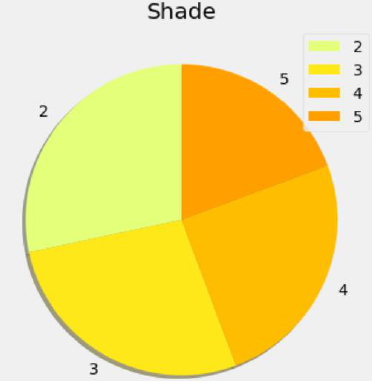
Figure 8. Pie chart for the column shade.